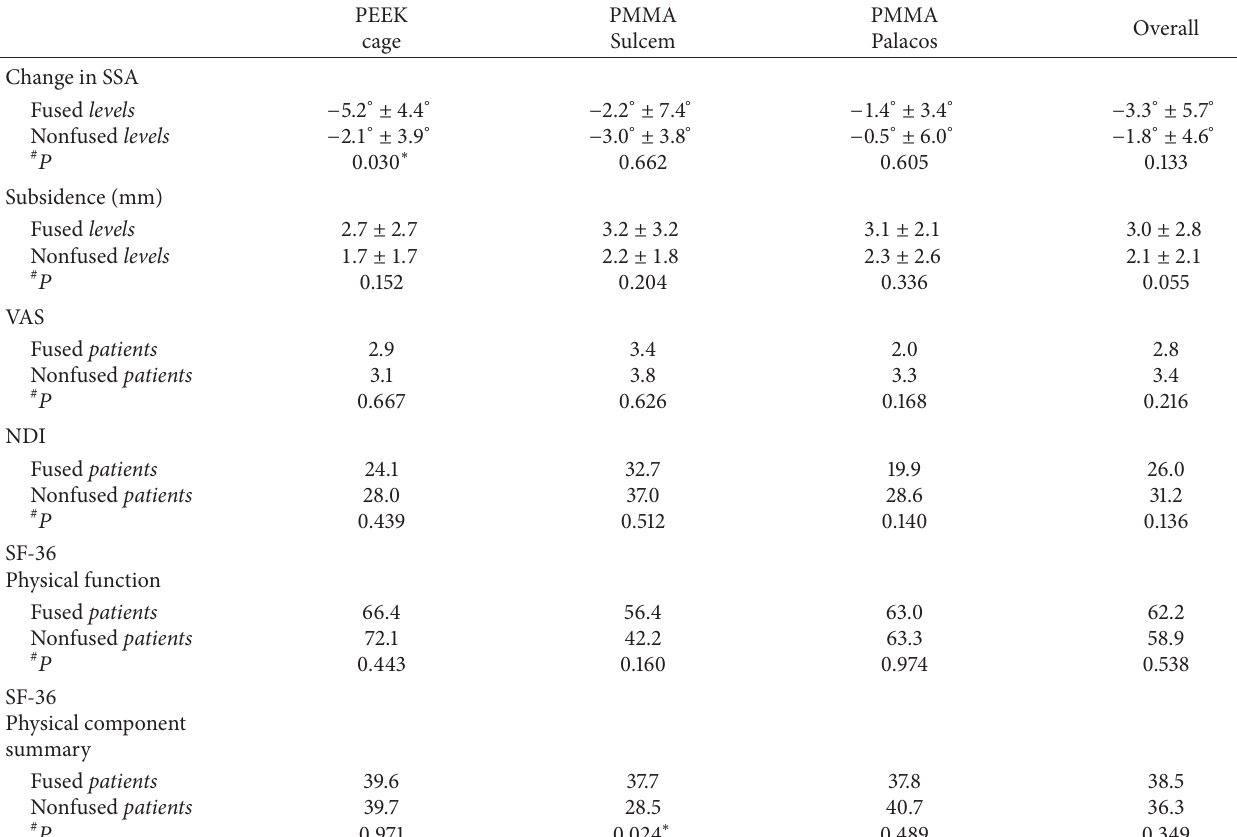
Table 4: Comparison of sagittal alignment, subsidence, pain level, and functional outcome according to fusion status.